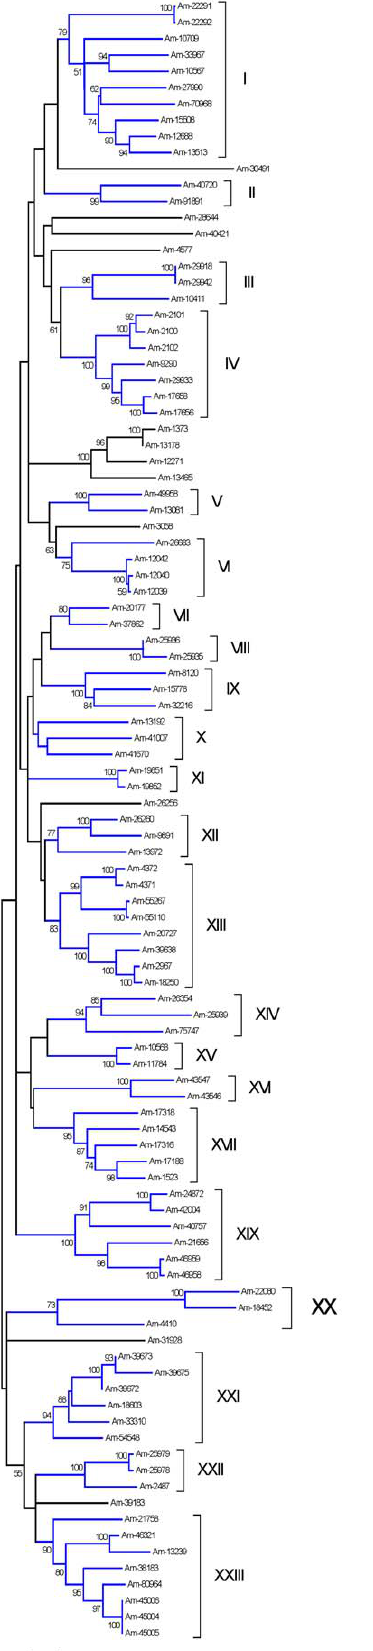
Figure 1. The salivary Kunitz family of proteins in Amblyomma maculatum . Bootstrapped phylogram (1,000 iterations) resulting from the alignment of 101 full-length protein sequences containing one or more Kunitz domains. The numbers on the nodes indicate the bootstrap support, and the bar at the bottom indicates 20% amino acid divergence. Clades with more than 70% bootstrap support are indicated by Roman numerals.